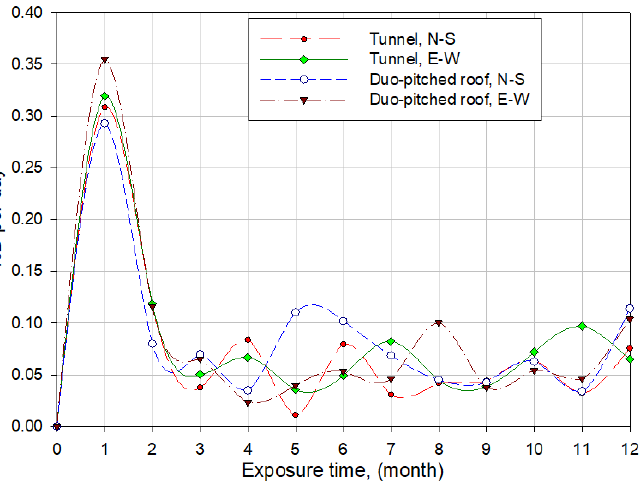
Figure 9. Time course of the degradation rate of the cover transmittance estimated for the two green- house prototypes oriented in the N–S and E–W directions and exposed to the arid climatic agents. Table 1. Average of the degradation rates (%) per day for both orientation and shape.